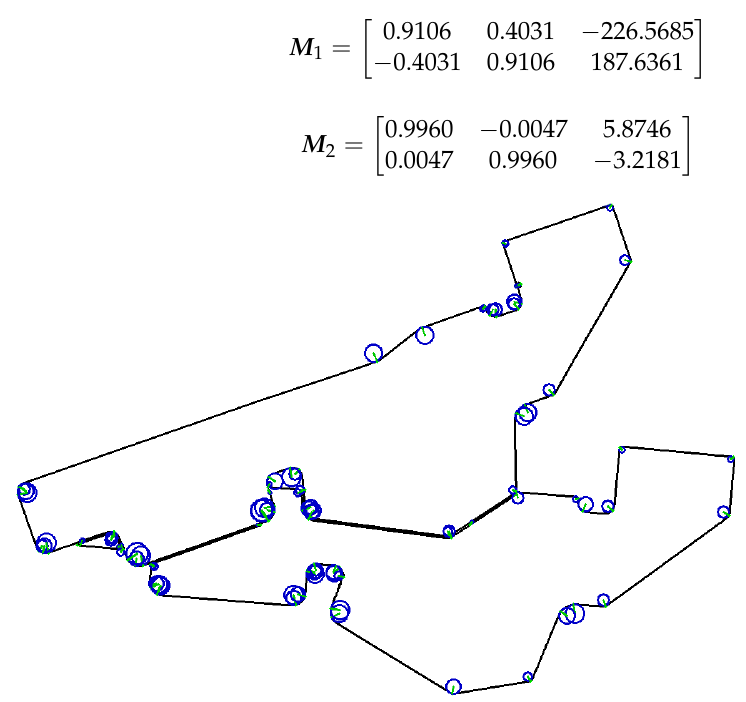
Figure 20. Corner points of sheet metal part contours.